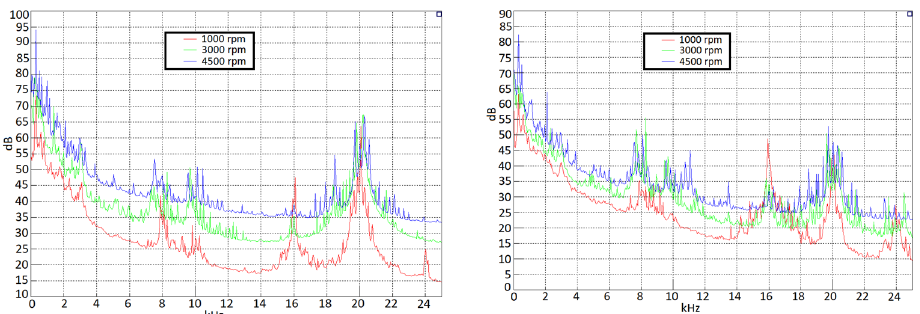
Figure 23. Noise at different rotational speeds at 20 Nm load at 45 deg current angle: microphone next to the machine ( left ) and hung 1.5 m above ( right ) .